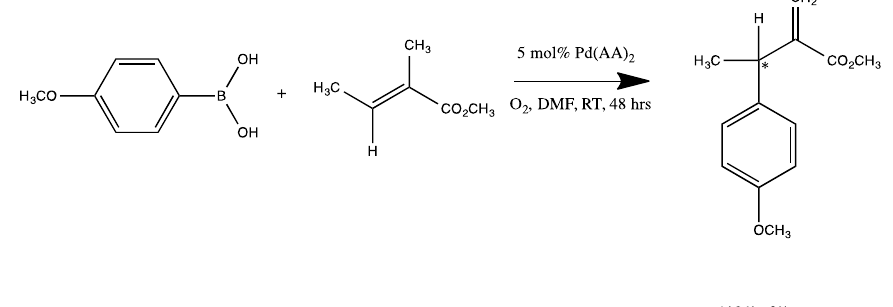
Figure 20. Reaction scheme and product distributions of the coupling reaction between 4-methoxyphenylboronic acid and methyl tiglate.